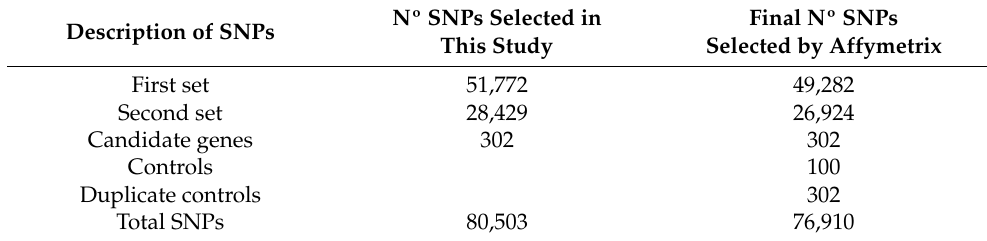
Table 4. Number of SNPs selected for the microarray.